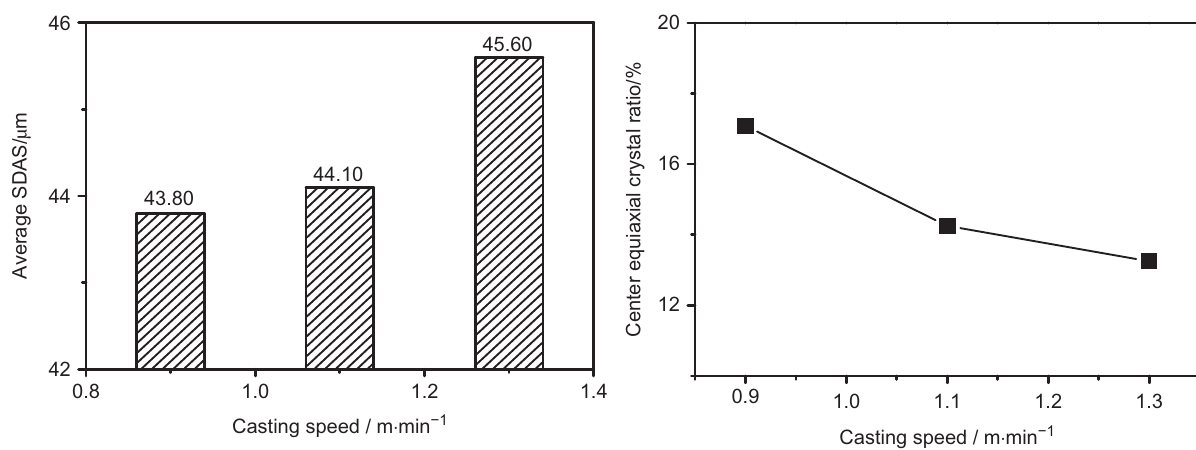
Figure 8: The simulated statistical results of SDAS and equiaxed crystal ratio at different casting